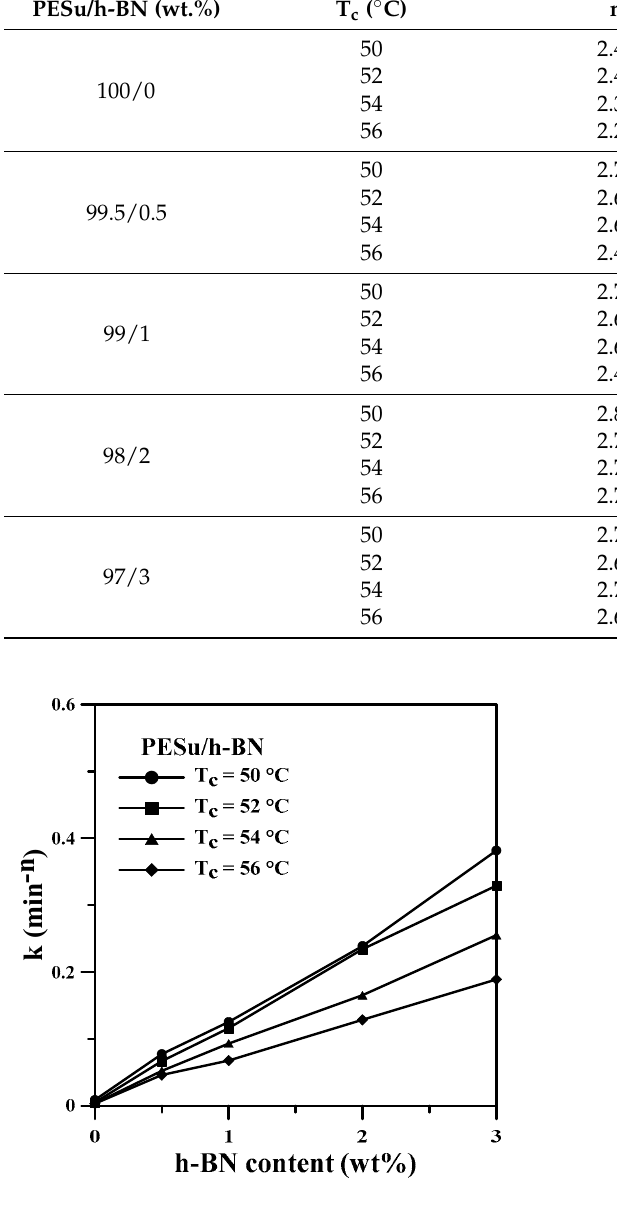
Figure 5. Plots showing k values of different crystallization temperatures for PESu/h-BN composites with the change of h-BN content in the composites.